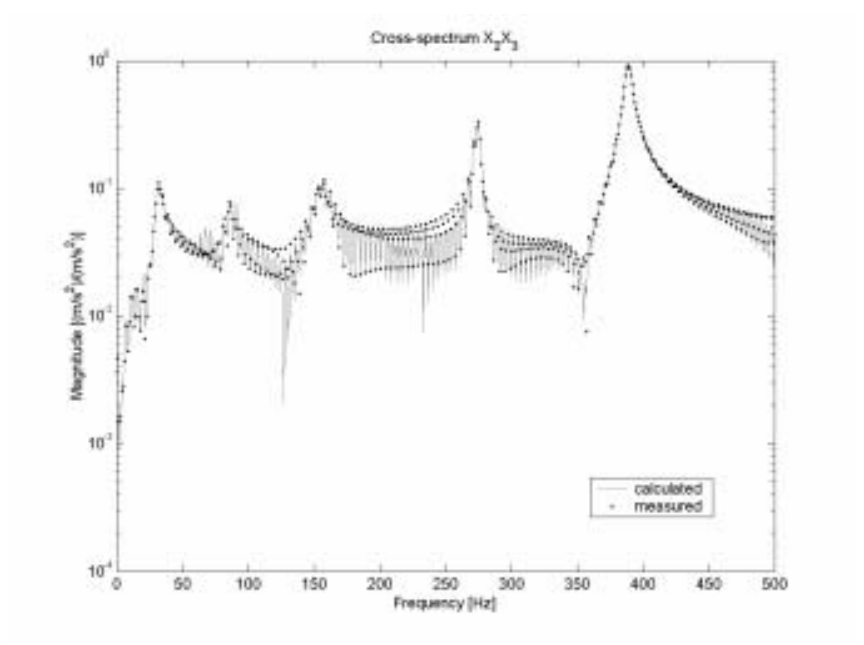
Fig. 5. Calculated and measured spectral